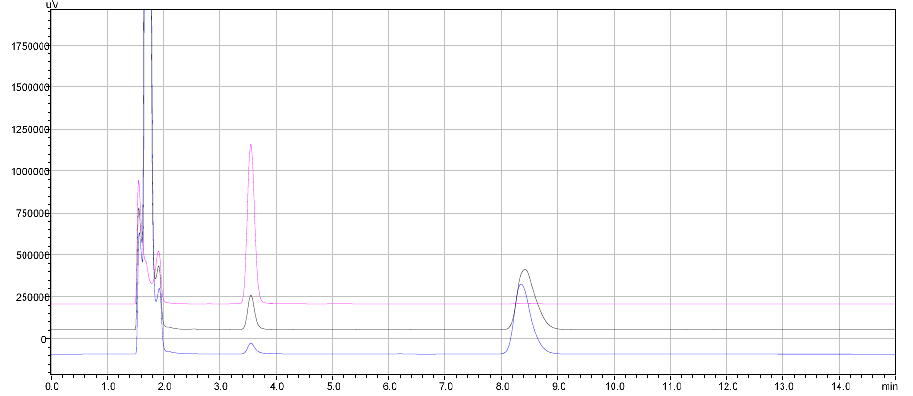
Figure 4. Representative HPLC chromatograms from the oxidation study of GSH at time intervals of t = 0 min (fuchsia line), t = 90 min (black line) and t = 180 min (blue line).